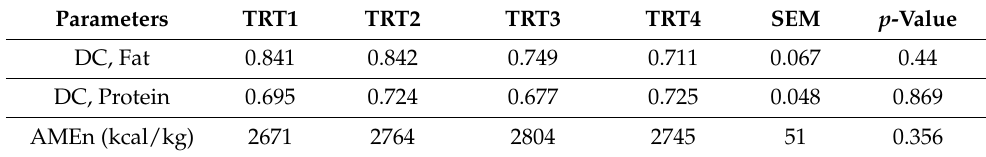
Table 3. Apparent Nutrient Digestibility of Full-fat and Defatted Soybean Meal in Layer Hens